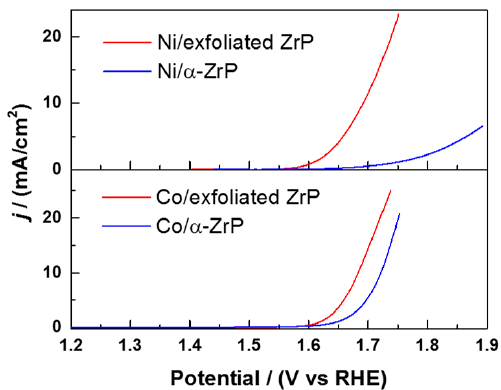
Figure 10. iR-compensated linear sweep voltammograms of Ni-modified and Co-modified ZrP catalysts in 0.1 M KOH. Reproduced from [47], with permission from the American Chemical Society, 2019.